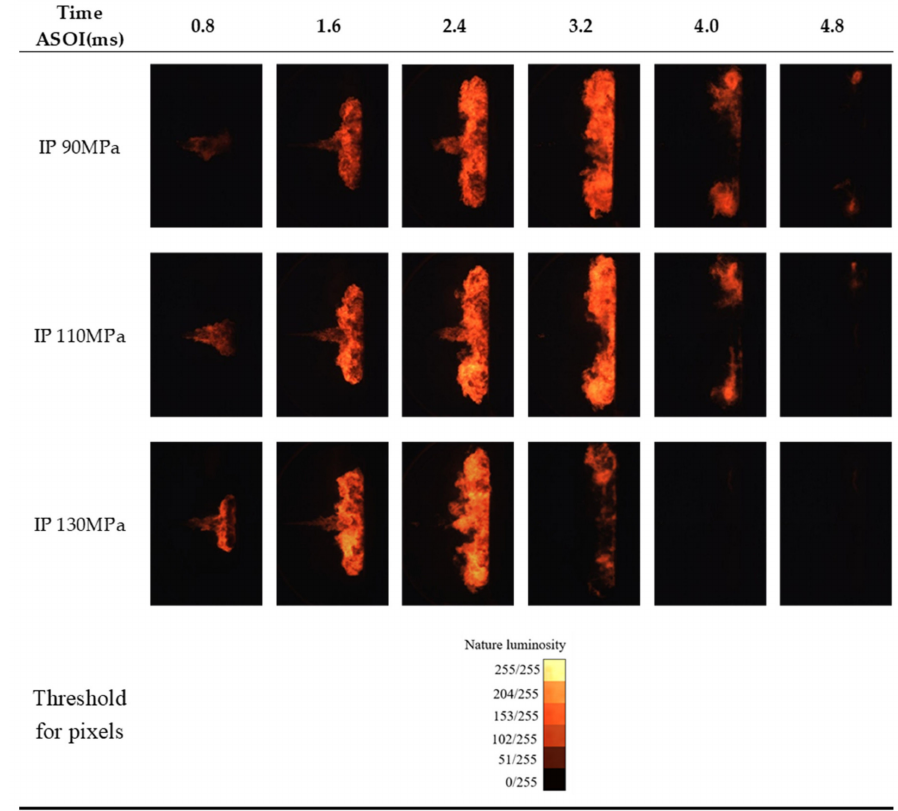
Figure 12. Impinging flame images under di ff erent